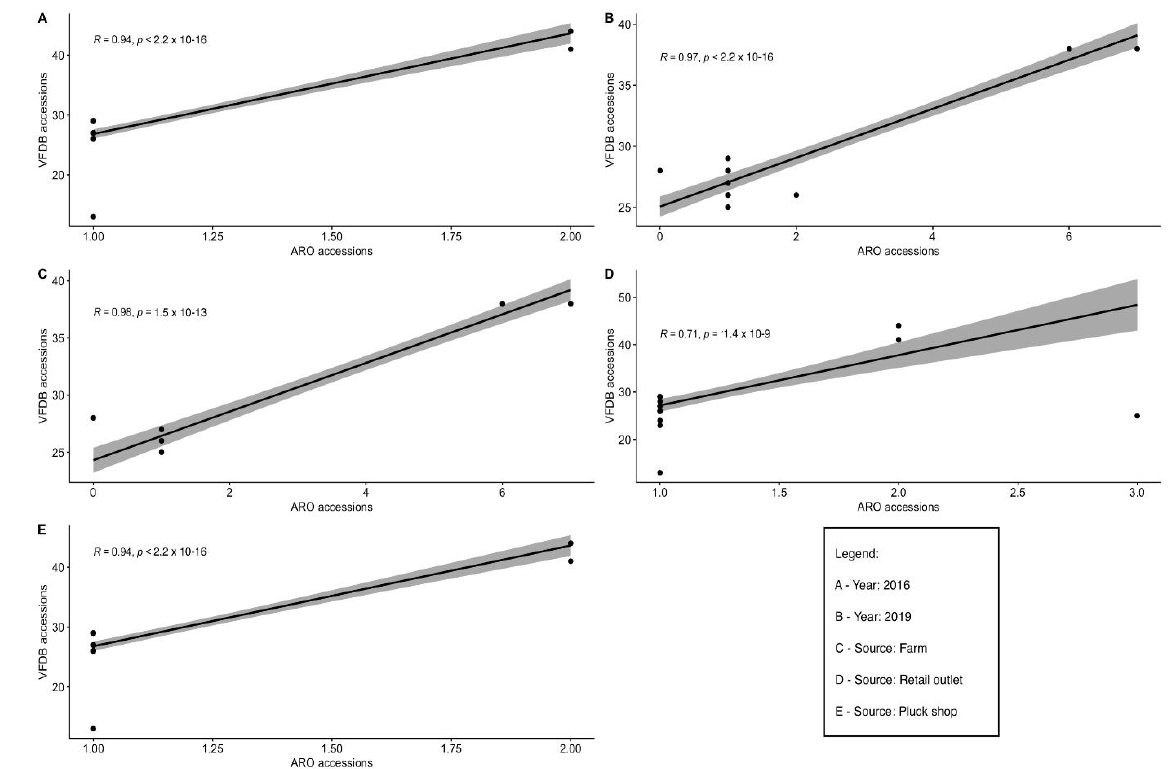
Figure 1. VFDB accessions (virulence) versus ARO accessions (AMR) ( A – E ).